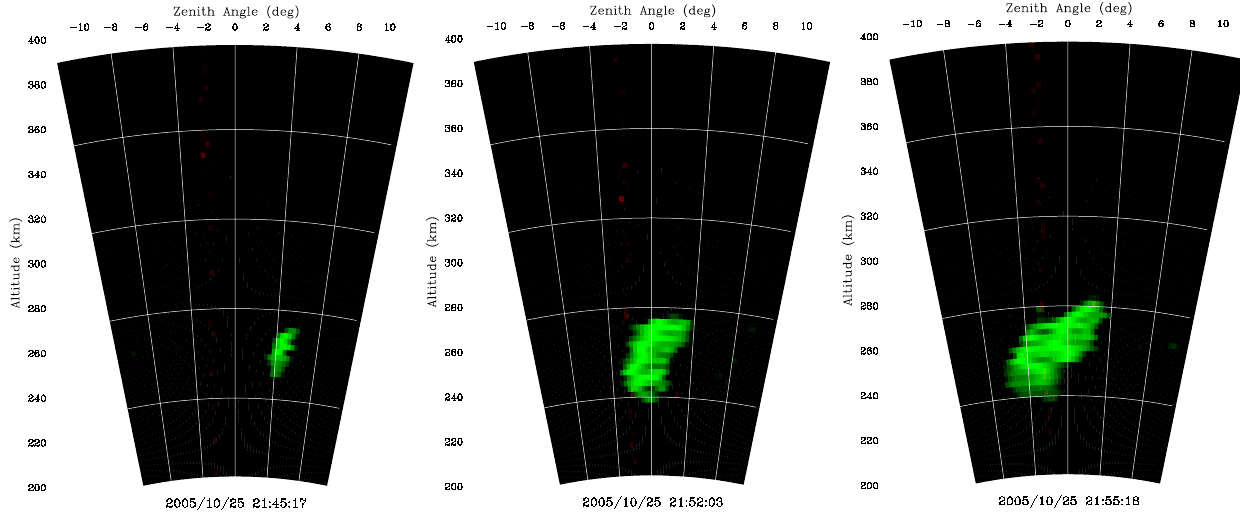
Fig. 3. Sequence of in-beam radar images showing a bottom-type layer. The images shows that the layer is created to east of the radar location and moves in westward direction entering the radar